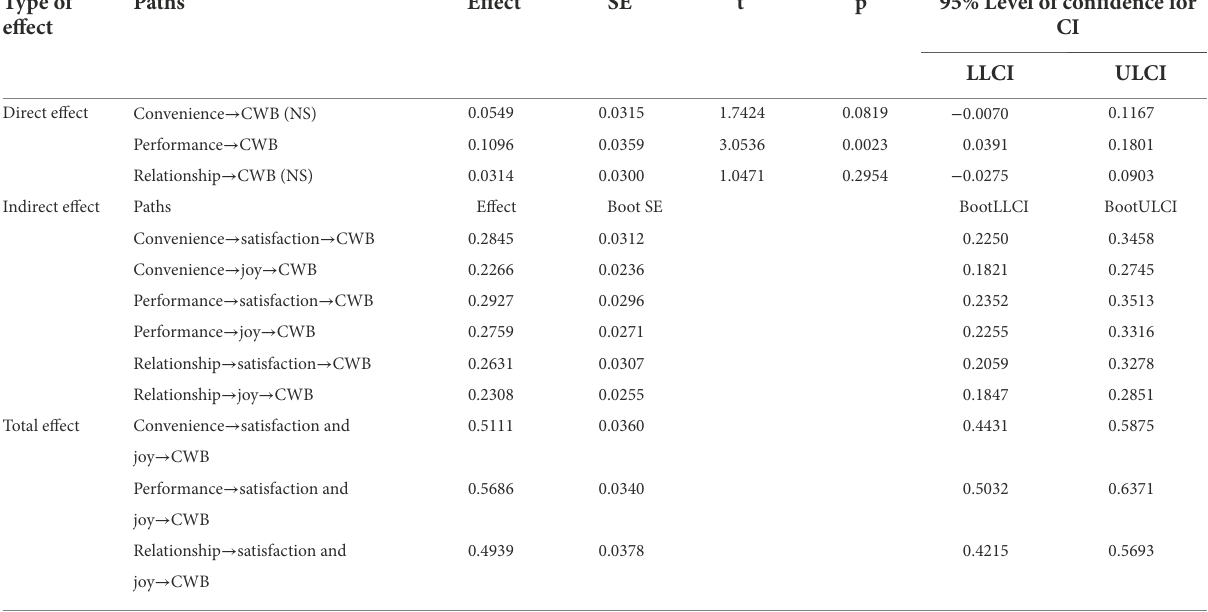
TABLE 6 Test results of mediating